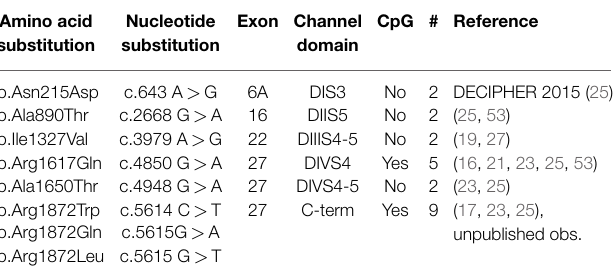
TABLE 3 | Recurrent de novo mutations of SCN8A in epileptic encephalopathy . Amino acid substitution